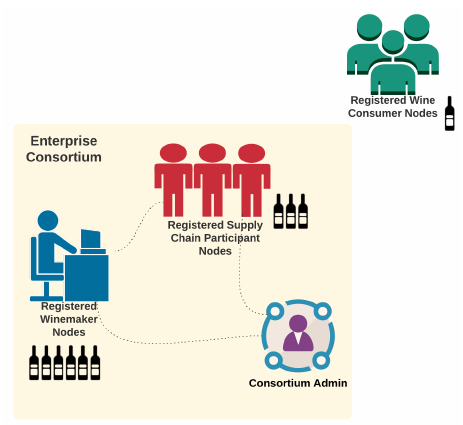
Figure 2. Enterprise Consortium of